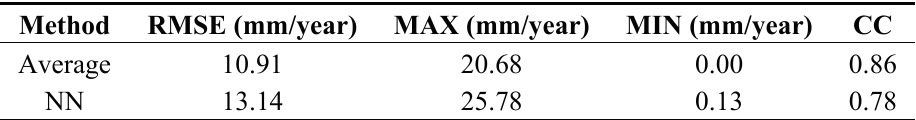
Table 2. Comparison of average velocity between ALOS-PALSAR QPS results and leveling